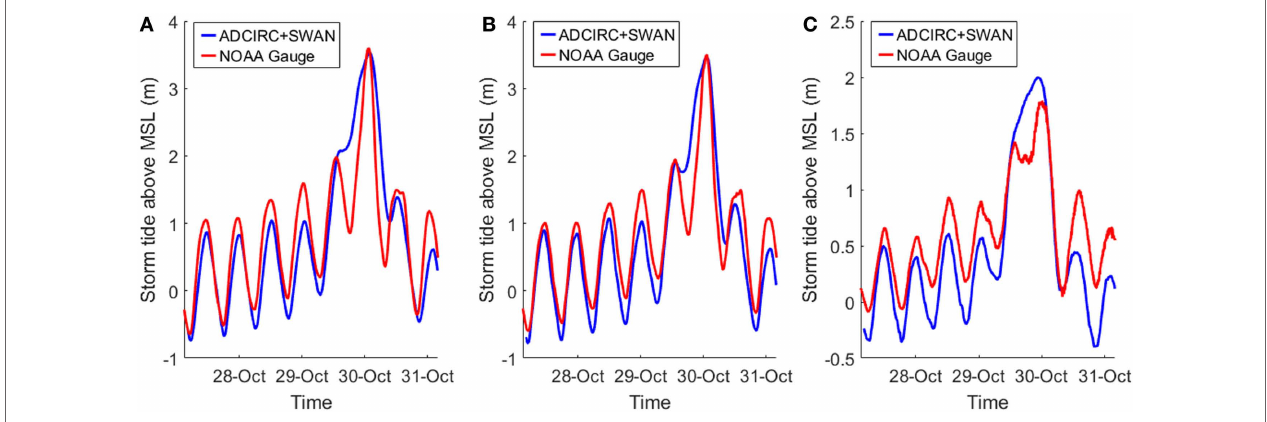
FIGURE 3 | Comparison of ADCIRC + SWAN simulated storm tide above mean sea level (m) and observed water levels at NOAA gage stations located at (A) Bergen Point, NY, (B) the Battery, NY, and (C) Montauk, NY. The locations of the gages are, respectively, shown as triangle, circle, and square markers in Figure 1 .